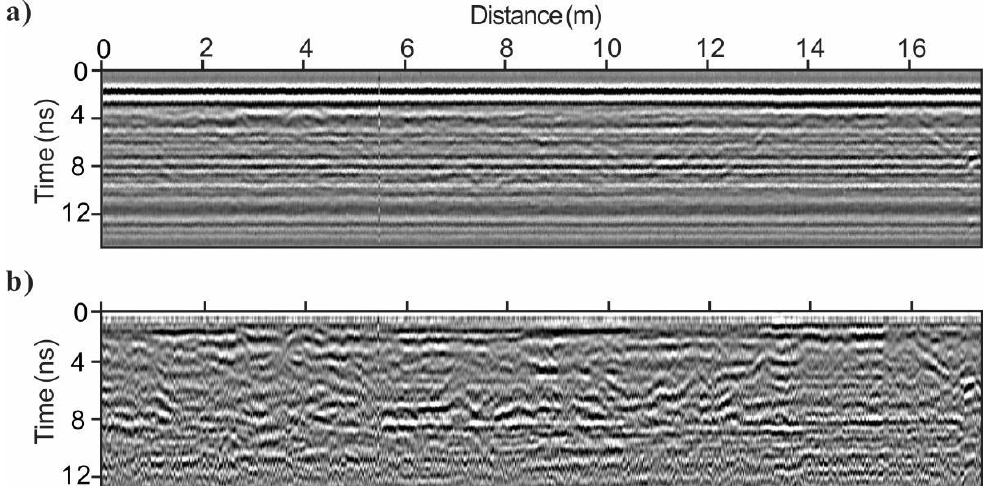
Figure 3. Inline profile of the 3D GPR data: ( a ) before preprocessing; ( b ) after preprocessing.